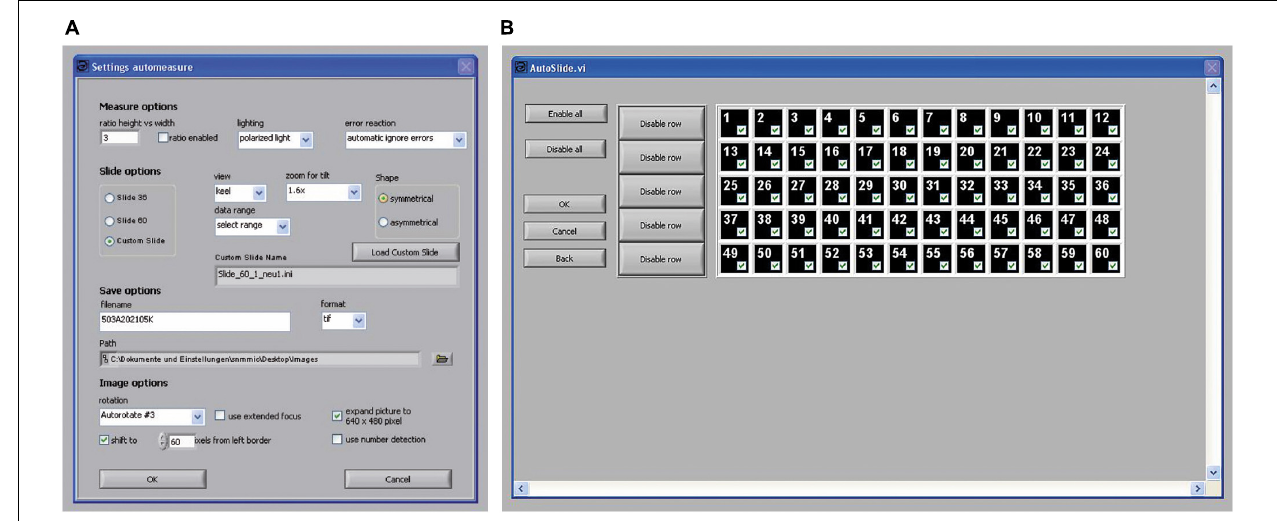
FIGURE 9 | Control panels of the program AMOR 4.2 in the automatic mode. (A) A panel for setting parameters in the automatic mode. (B) A panel for the selection of fields of the slide shall be processed. Each of the numbered fields can be selected separately by mouse